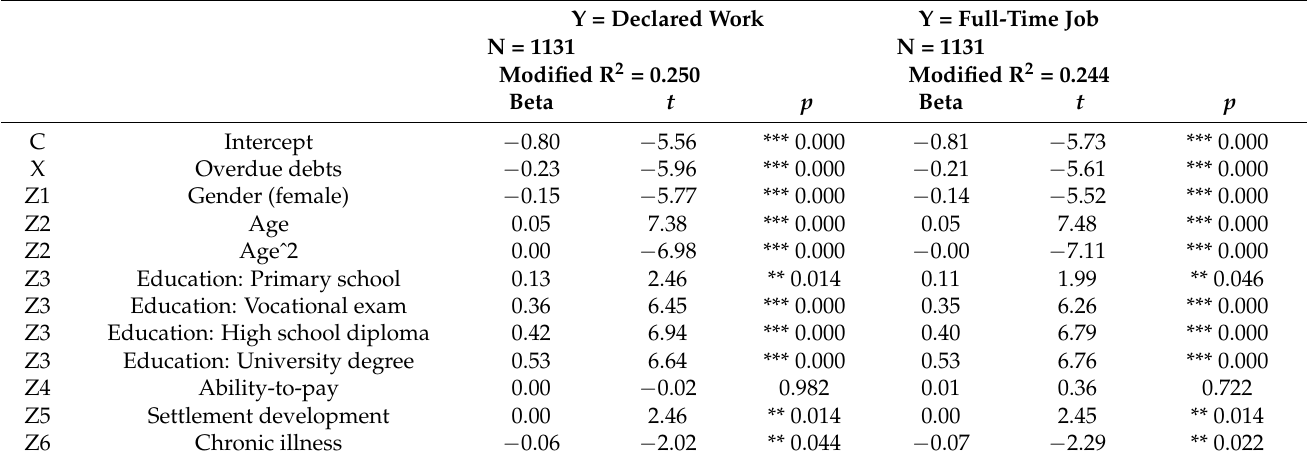
Table 3. Overdue debts and